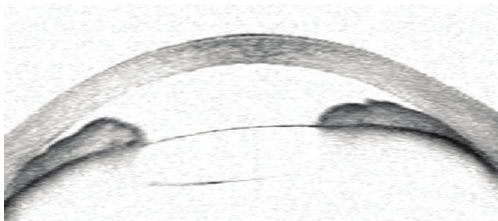
Figure 3: Preoperative anterior chamber optic coherence tomogra- phy picture of the right eye in Case 1. Anterior chamber depth was 2.10